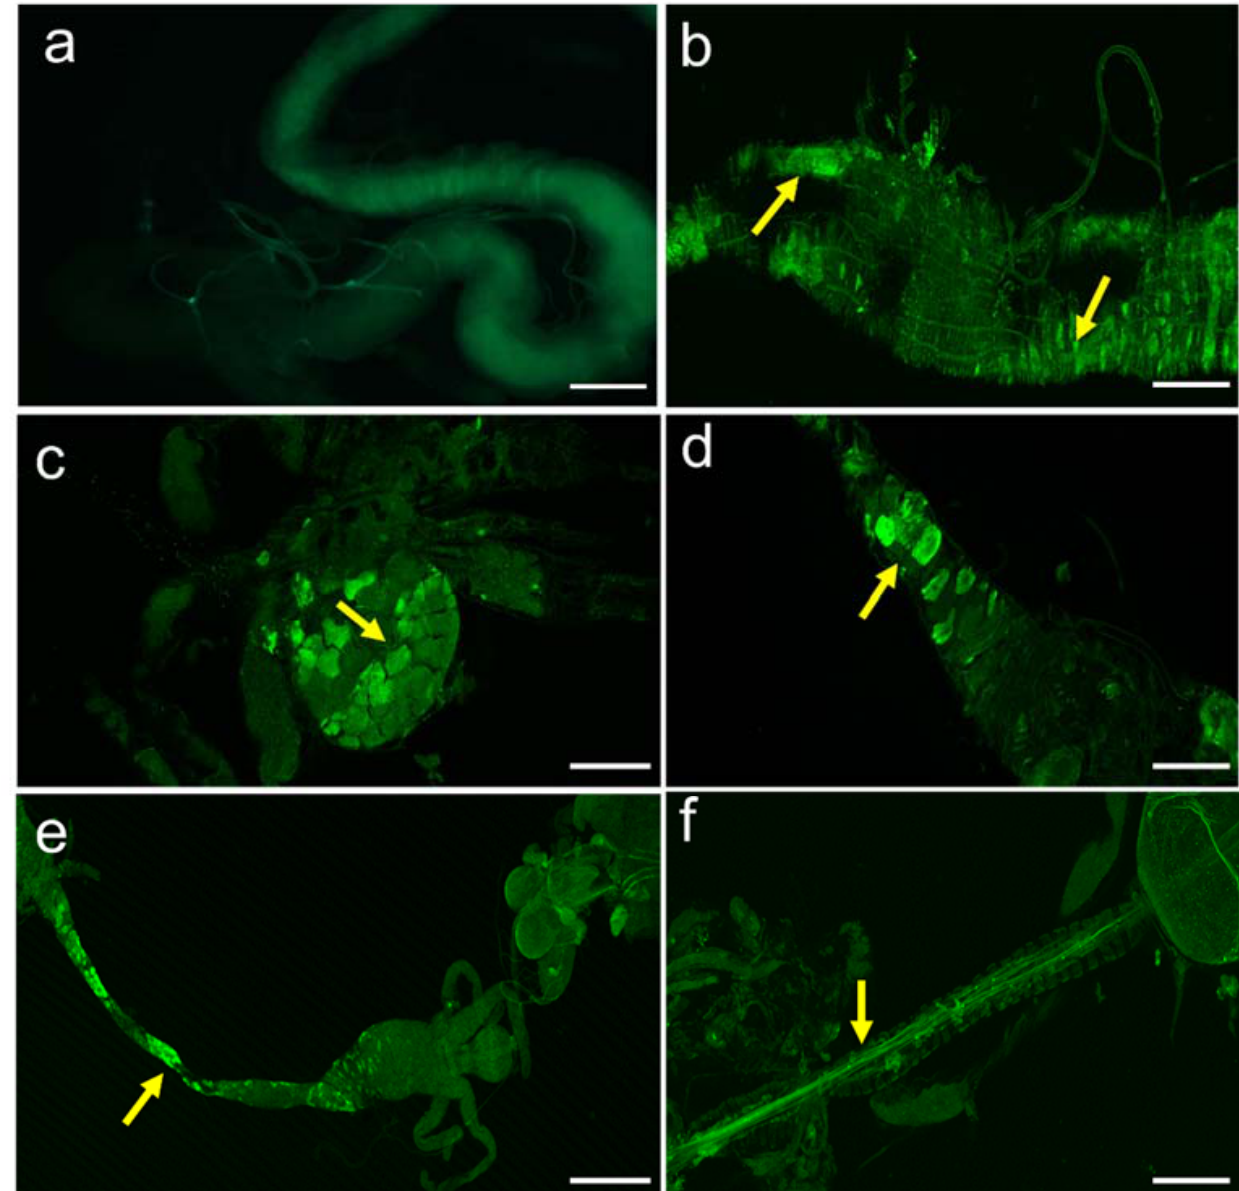
Figure 4. Expression pattern of dopamine receptor Dop1R1 in the nerves and enterocytes of Drosophila larvae stained immunohistochemically using the anti-GFP antibody. ( a ) Negative control (i.e., the midgut of larvae that did not show up the expression of Dop2R). The arrows in ( b ) refer to the expression of Dop1R1 in the midgut cells, ( c ) in proventriculus, and ( d ) in the foregut cells. Dop1R1 expressed in ( e ) foregut cells, and (f) nerves innervating the foregut. Scale bars: ( b , d ) 50 µ m, ( a , c , f ) 100 µ m, and ( e ) 500 µ m.